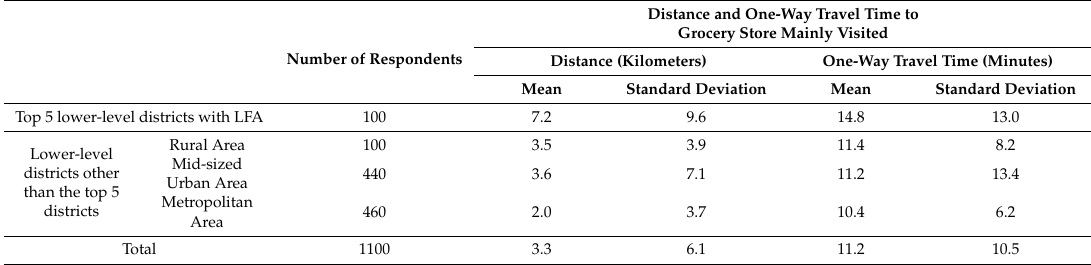
Table 6. Average distance and one-way travel time to the grocery store mainly visited. Distance and One-Way Travel Time to Grocery Store Mainly Visited Number of Respondents Distance (Kilometers) One-Way Travel Time (Minutes) Mean Standard Deviation Mean Standard Deviation Top 5 lower-level districts with LFA 100 7.2 9.6 14.8 13.0 Lower-level districts other than the top 5